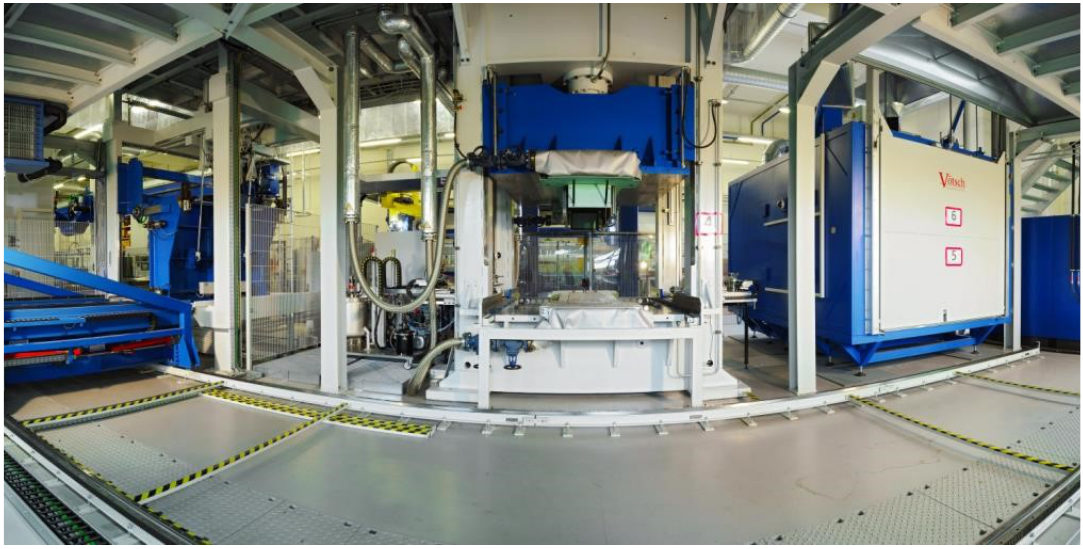
Figure 8: RTM-section containing transport system, opening station, press and cure oven (f.l.t.r.).